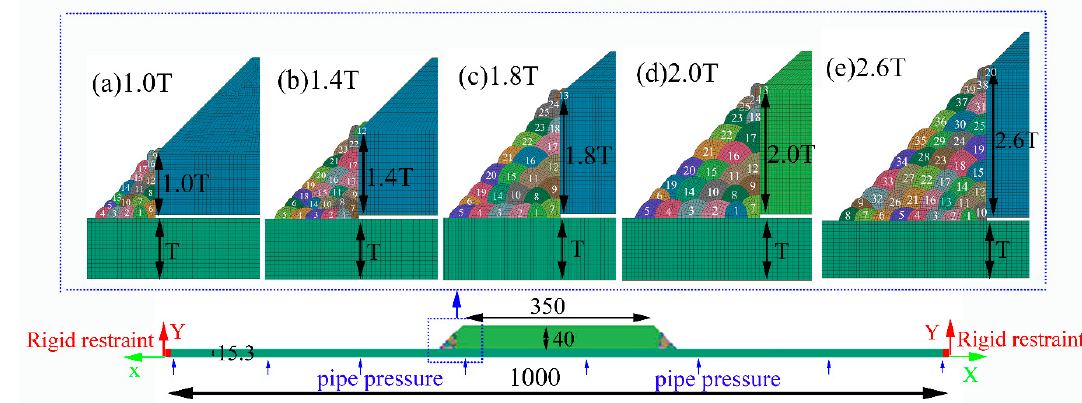
Figure 5. Finite element model of sleeve repair welding (mm): ( a ) 1.0T, ( b ) 1.4T, ( c ) 1.8T, ( d ) 2.0T, ( e ) 2.6T.